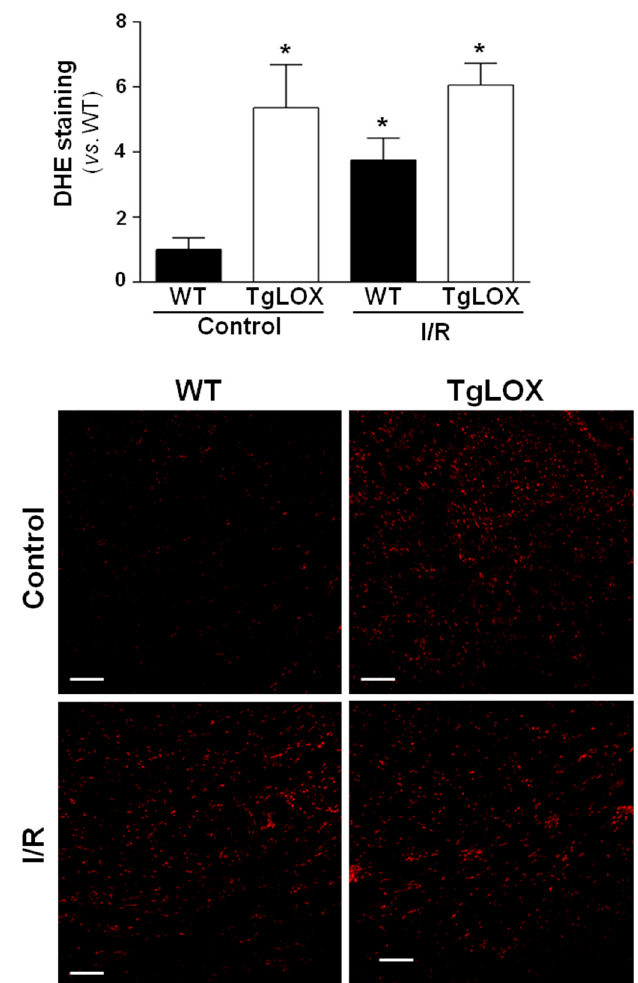
Figure 4. Influence of LOX transgenesis on cardiac reactive oxygen species (ROS) generation after ischemia-reperfusion injury. Superoxide anion levels were assessed by dihydroethidium (DHE) staining in isolated hearts from wild-type (WT) and TgLOX mice subjected to normoxic perfusion (control) or to global ischemia-reperfusion (I/R). DHE staining was quantified at 5 min of reperfu- sion. Representative images are shown (bars: 100 μ m). At least 4 fields from n = 3 mice in each group were quantified. Data, are expressed as mean ± SEM. * p < 0.05 vs. WT normoxic hearts (Kruskal– Wallis test).